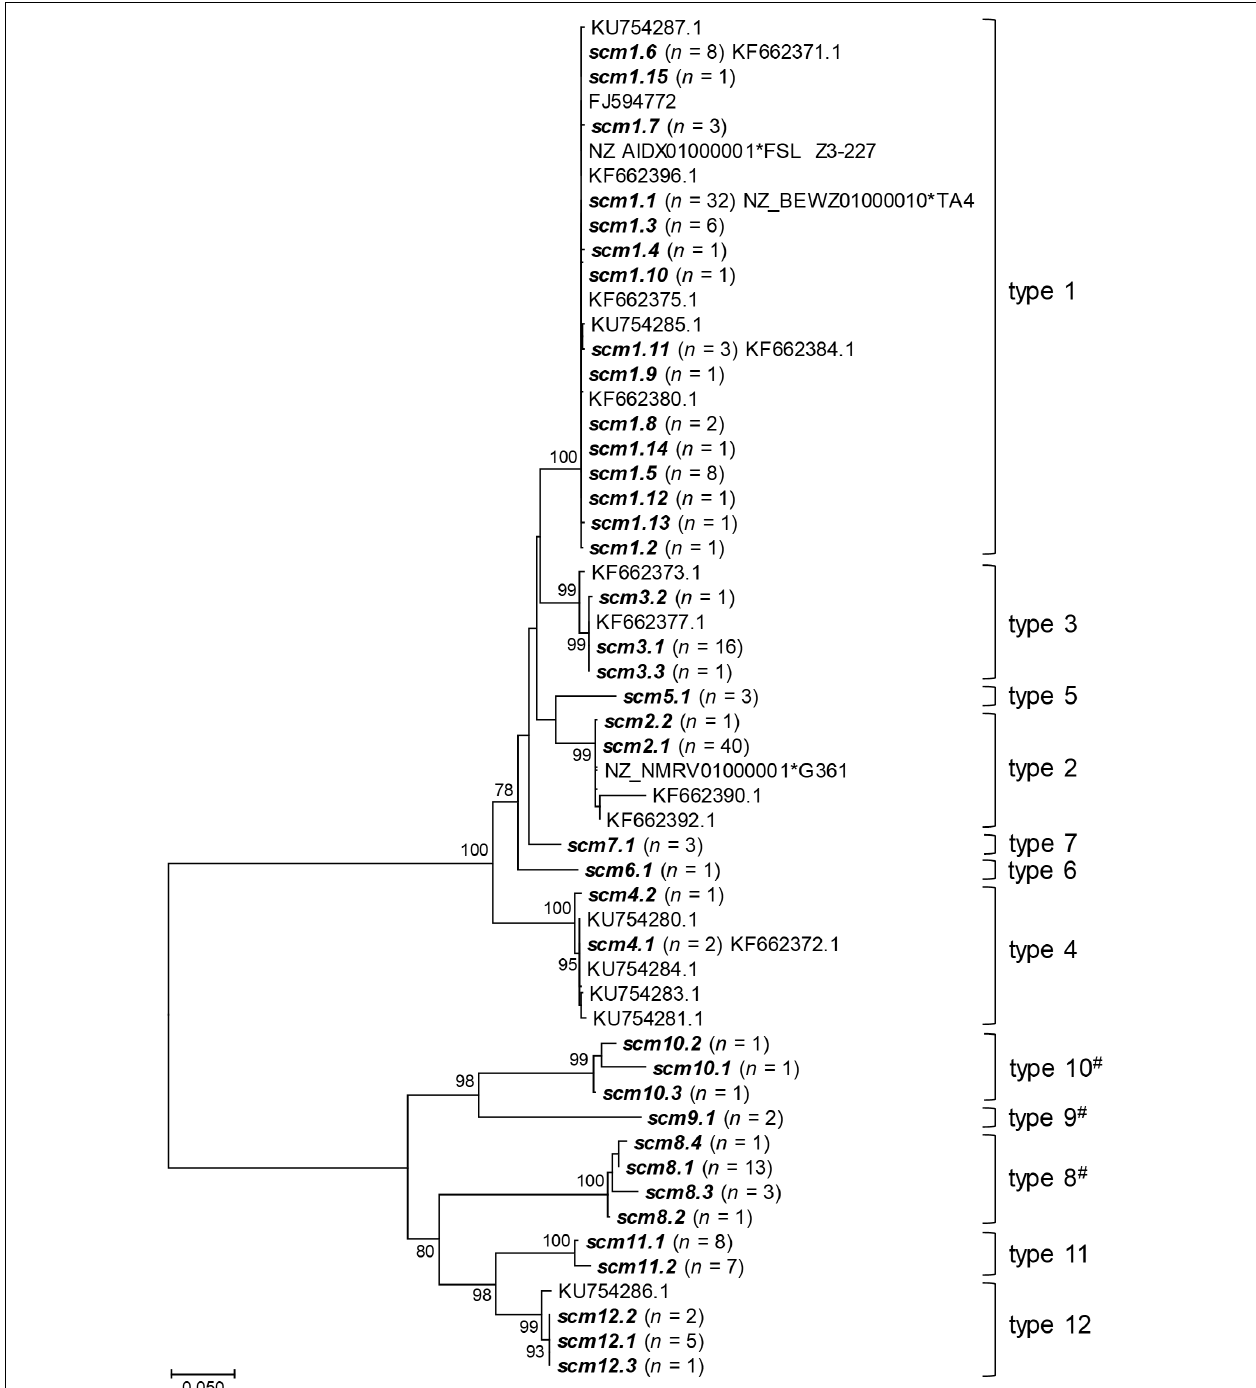
FIGURE 2 | Neighbor-joining tree of scm alleles found among S. canis isolates. The scm alleles found in the current study are shown in bold and the numbers of isolates presenting each allele are indicated in brackets. Sequences from other studies are identified by their GenBank accession number and include those previously described by Timoney et al. (2017), the original scm sequence (FJ594772) described by Yang et al. (2010) and those extracted from S. canis genomes (indicated by an asterisk following the accession number and the name of the strain). scm alleles 1.16 to 1.18 have premature stop codons and were not included in the tree. Branches supported in the bootstrap test (1,000 replicates) by > 75%, have the values shown next to the branches. The tree is drawn to scale, with branch lengths being in the same units as those of the evolutionary distances used to infer the phylogenetic tree. The evolutionary distances were computed by the Kimura two-parameter method and are in units of number of base substitutions per site. #indicates scm types that correspond to previously identified emm types, namely stG1389 ( scm8 ) , stg1451 ( scm9 ), and stG663 ( scm10 ).